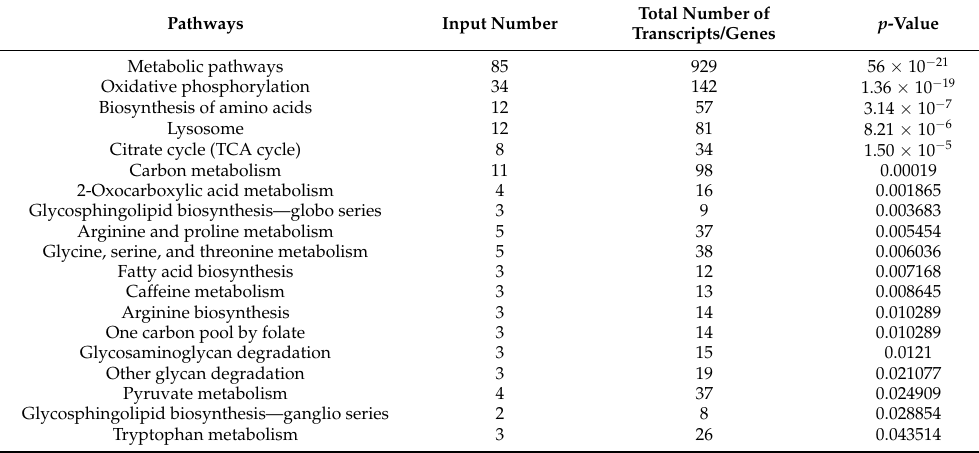
Table 4. Significant pathways of differentially regulated transcripts of